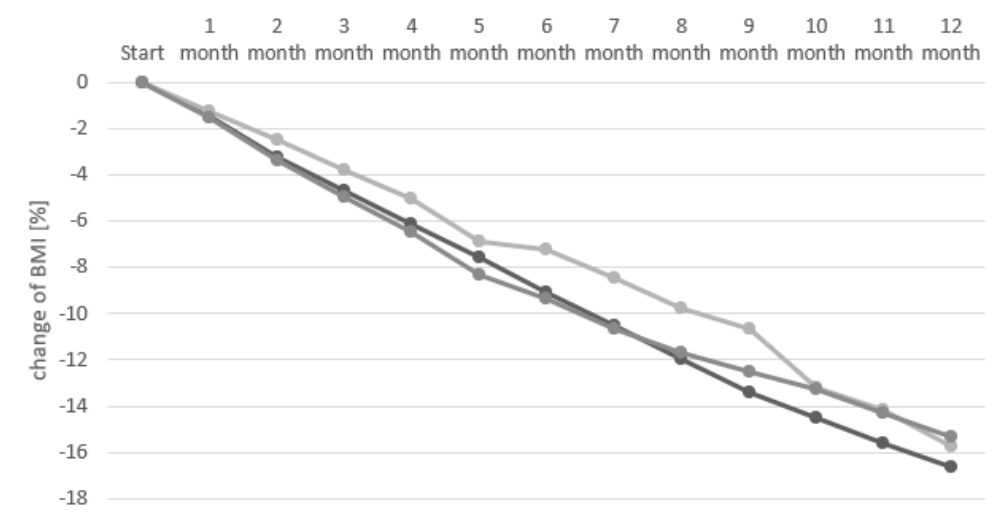
Figure 2. Rate of decline in BMI over 12 months. BMI: body mass index. Additionally, in relative terms, i.e., reduced percentage of BMI, a more significant reduction ( p = 0.007) was found in the overweight group (16.6%). The group with class 1 obesity reduced BMI by 15.7%, and the group with class > 1 obesity by 15.4% (these values were not significantly different). The t-test results indicated significant differences between the body weight of the participants in the three-month intervals, between the start and the 3rd month ( − 5.03 ± 2.44 kg), the 3rd month and the 6th month ( − 4.18 ± 1.81 kg), the 6th month and the 9th month ( − 3.43 ± 1.5 kg), 9th month and the 12th month ( − 2.6 ± 2.15 kg) and between the start and 12th month ( − 15.27 ± 5.11 kg) ( p < 0.0001 for all periods). These differences were also statistically significant in the individual BMI groups. More information about the changes in BMI in every month is presented in Figure 3.